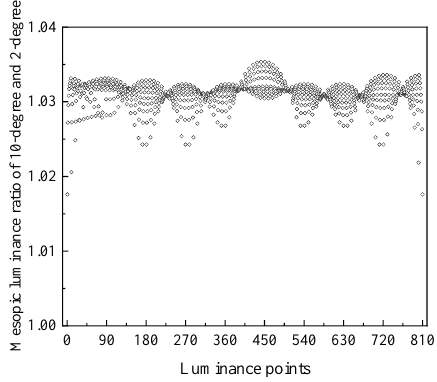
Figure 11. Mesopic luminance ratios of 10-degree and 2-degree SSCs of 810 luminance points. The mean ratio is 1.03, which yields a difference of ~3%.